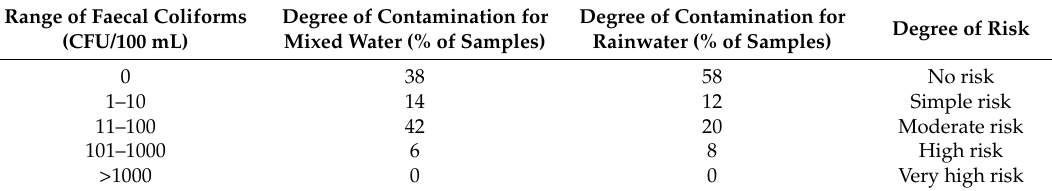
Table 5. Water contamination with faecal Coliforms in Yatta cisterns.